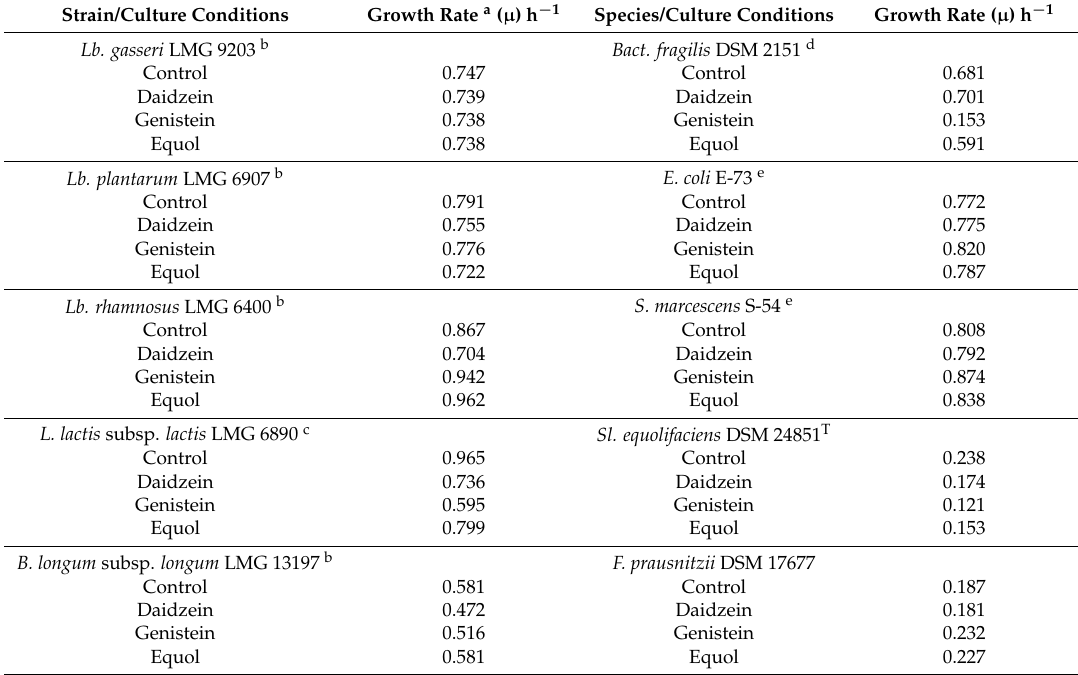
Table 2. Growth rate of selected bacterial strains in cultures supplemented with daidzein, genistein, or equol at a final concentration of 32 µ g mL − 1 as compared to that in control cultures without isoflavone